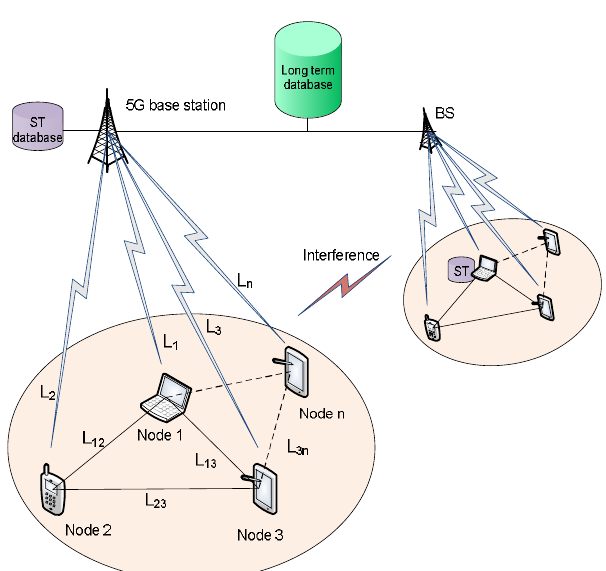
Figure 1. Network model for social-aware D2D